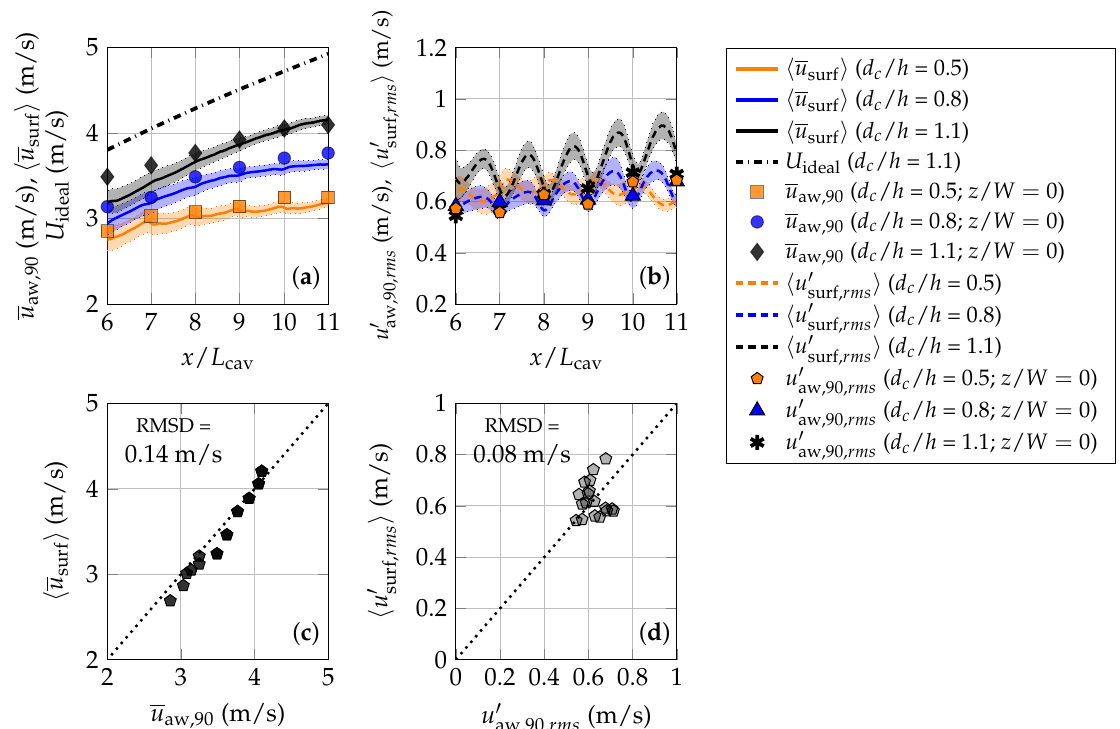
Figure 7. Comparison of transverse averaged free-surface velocities with interfacial velocities in spillway centerline at h 90 for all present flow conditions; shaded areas represent the standard deviation of streamwise velocities over the chute width: ( a ) comparison of streamwise air-water free-surface velocities and interfacial velocities; ( b ) comparison of streamwise air–water surface velocity fluctuations and interfacial velocity fluctuations ( c ) comparison of mean velocities ( d ) comparison of velocity